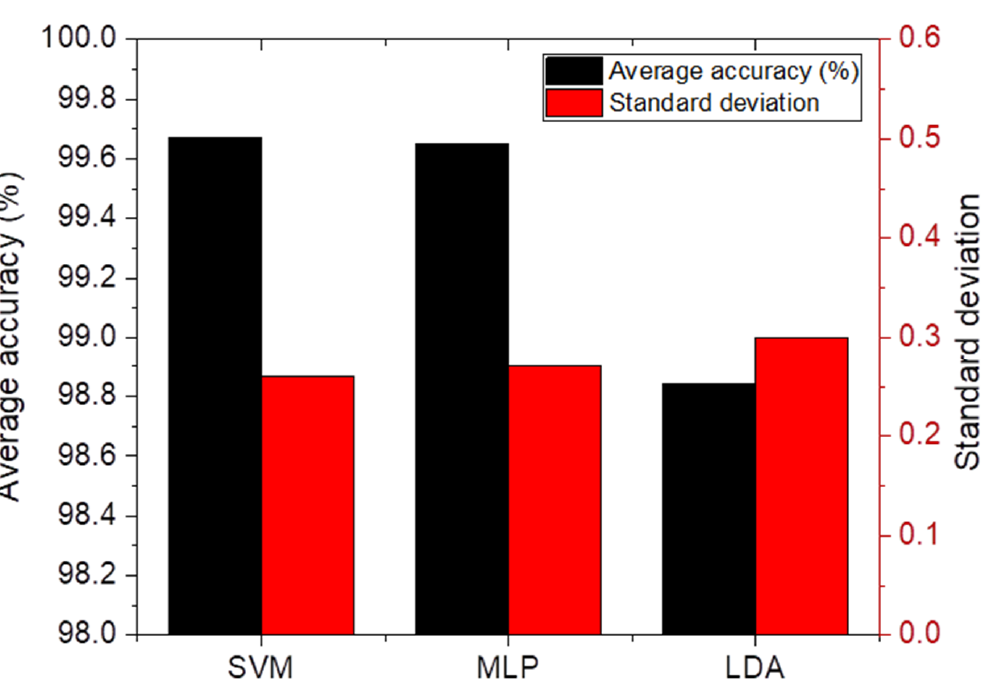
Figure 14. Average accuracies of 10-fold cross validation over training data and their standard deviation for three developed models.